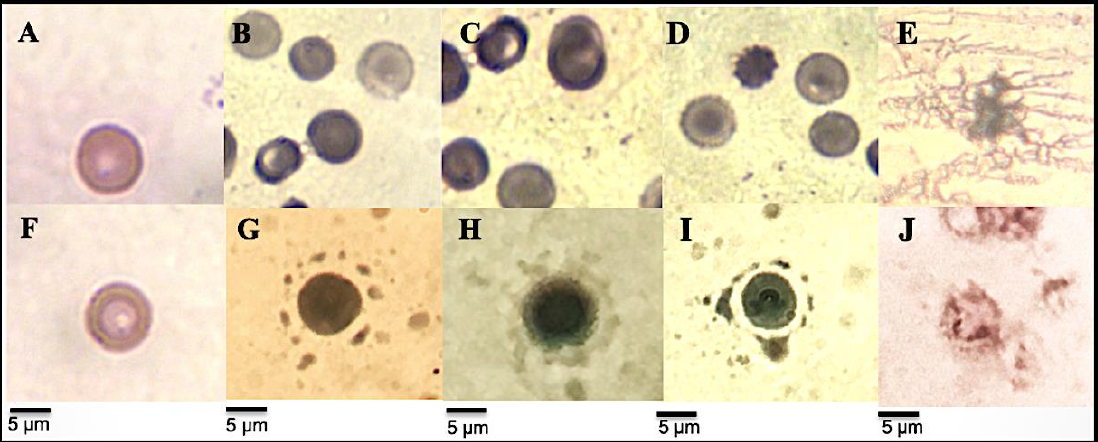
Figure 4. Morphological change micrography of human erythrocytes caused by different methods of induction of hemolysis to evaluate anti-inflammatory activity. Heat-Induced hemolysis: ( A ) Healthy erythrocytes; ( B – D ) erythrocytes + extracts (acetonic, methanolic, and ethanolic extract, respectively) + 55-degree hot water bath; ( E ) erythrocytes subjected to a temperature of 55-degrees in a hot water bath. Hypotonicity-Induced hemolysis: ( F ) Healthy erythrocytes; ( G – I ) erythrocytes + extracts (Acetonic, methanolic and ethanolic extract, respectively) + hypotonic solution; ( J ) erythrocytes + hypotonic solution. Micrograph to × 100. The bar represents a scale of 5 μm